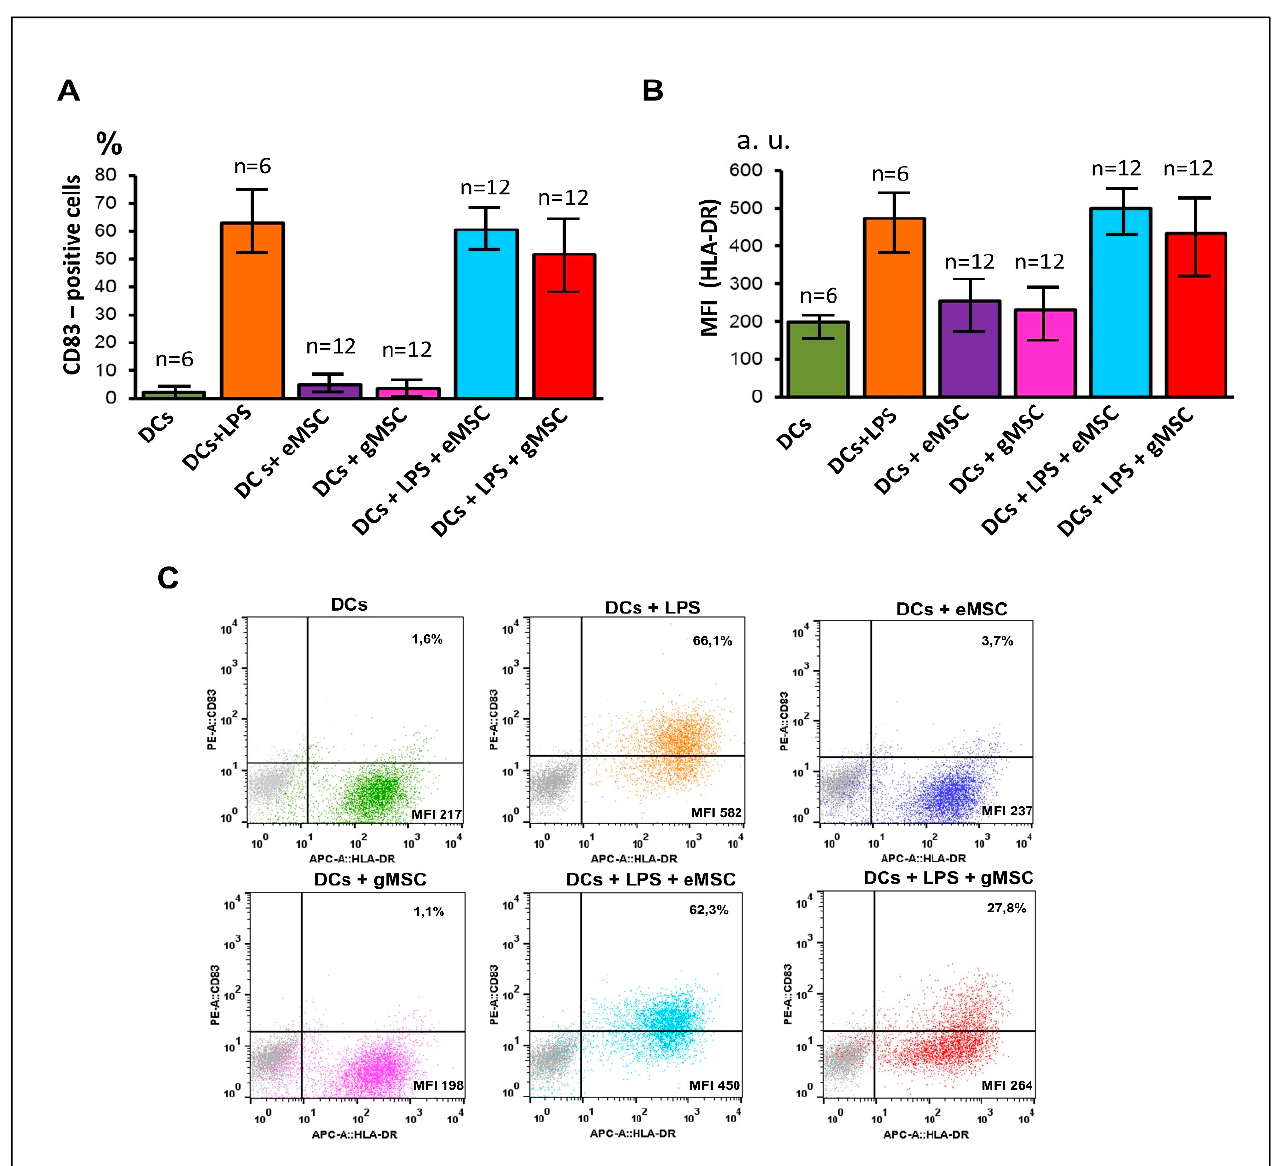
Figure 4. Effects of stromal cells from eutopic or ectopic endometrium upon the maturation of dendritic cells (DC) in vitro. Immature DCs were co-cultured with stromal cells of eutopic (eMSC) or ectopic (gMSC) endometrium with or without LPS (DCs/MSC ratio 1:1). After 2 days, co-culture cells were double stained with fluorescent MoAbs against CD83 and HLA-DR and analyzed by flow cytometry to evaluate the percentage of DCs expressing the maturation marker CD83 ( A ) and the level of HLA-DR expression ( B ). Processed data combining all measurements of five pairs of MSC co-cultures are presented ( A , B ). Whiskers show the SD. MFI—median fluorescence intensity measured in arbitrary units (a.u.). ( C) The results of MSC-3 co-cultures (typical dot plots); gray dots denote isotype controls.